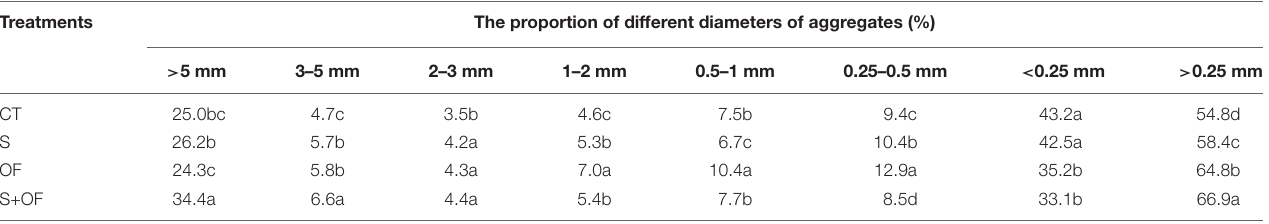
CT, conventional tillage; S, subsoiling; OF, organic fertilizer; S+OF, organic fertilizer organic fertilizer combined with subsoiling. Different lowercase letters within a column mean significant difference between treatments by LSD test (P < 0.05).